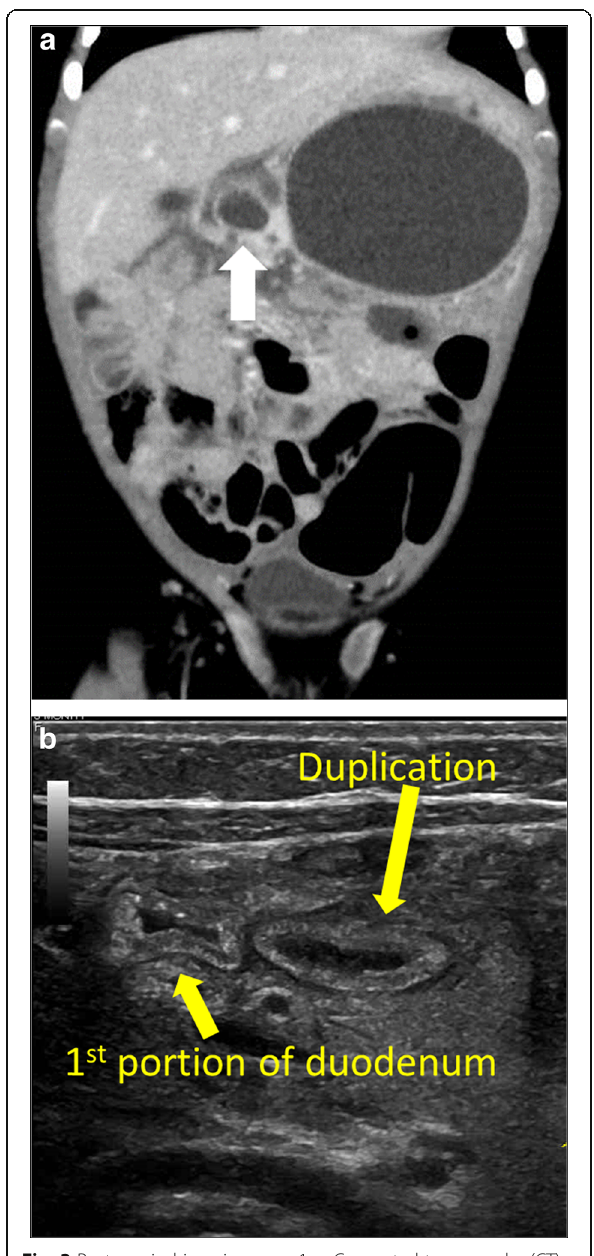
Fig. 3 Post-surgical imaging, case 1. a Computed tomography (CT) reveals a large pseudopancreatic cyst and a duodenal duplication cyst (white arrow) attached to the first portion of the native duodenum. b Ultrasonography (sagittal view) shows duplication at the first portion of the duodenum with hyperechoic mucosa surrounded by hypoechoic muscular layers